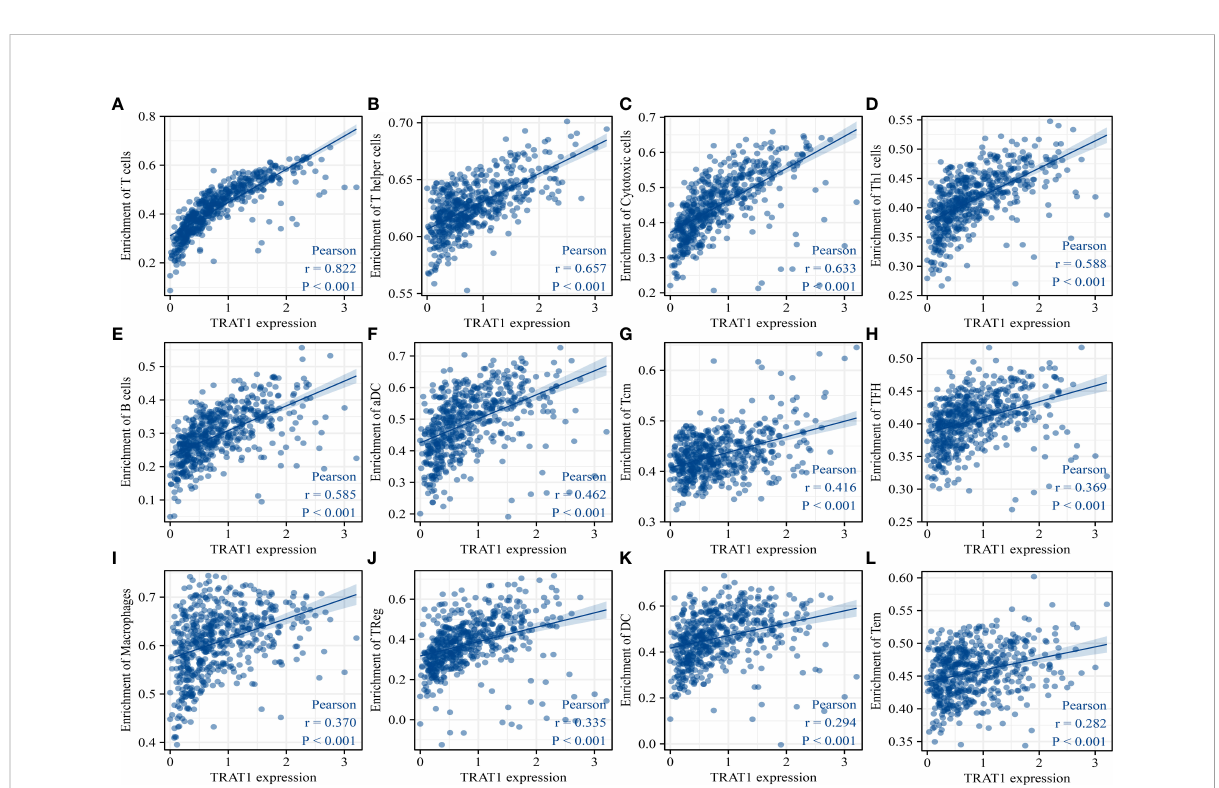
FIGURE 9 TRAT1 expression was signi fi cantly correlated with the populations of immune cells in LAC tissues. (A) T cells; (B) T helper cells; (C) Cytotoxic cells; (D) Th1 cells; (E) B cells; (F) aDC; (G) TCM; (H) TFH; (I) macrophages; (J) Treg; (K) DC; (L) TEM. LAC, lung adenocarcinoma; aDC, activated dendritic cells; TCM, central memory T cells; TFH, follicular helper T cells; Treg, regulatory T cells; TEM, effector memory T